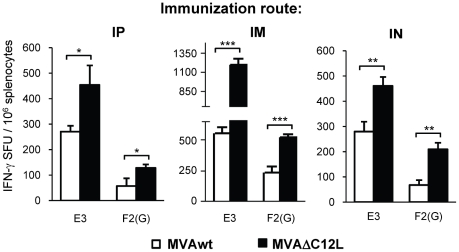
MVAΔC12L elicits higher cellular responses at lower doses of immunization and by different immunization routes.Groups of four BALB/c mice were immunized by intraperitoneal (IP) intramuscular (IM) or intranasal (IN) route with 107 pfu of MVAwt (white bars) or MVAΔC12L (black bars) and seven dpi specific-CD8+ T-cell responses against E3 and F2(G) peptides were evaluated in the spleen. The magnitude of the response was measured by IFN-γ Elispot assay after 24 hr stimulation. Background (RPMI control) subtracted results are depicted as mean IFN-γ spot forming units (SFU) per 106 splenocytes ± SD. Statistically significant differences: *p<0.05, **p<0.01, ***p<0.001.